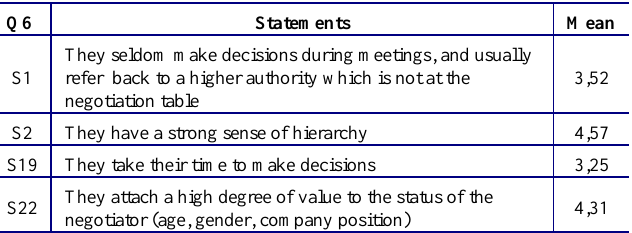
Table 6: Importance of hierarchy and